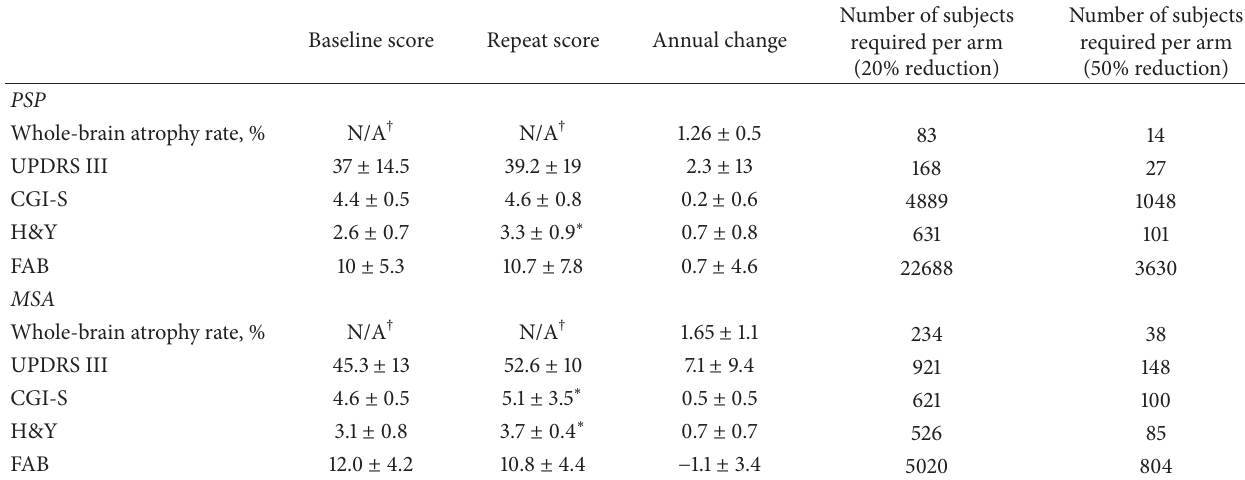
Table 2: Baseline, follow-up scores, and estimates of the sample sizes in PSP ( 𝑁 = 12 ) and MSA ( 𝑁 = 8